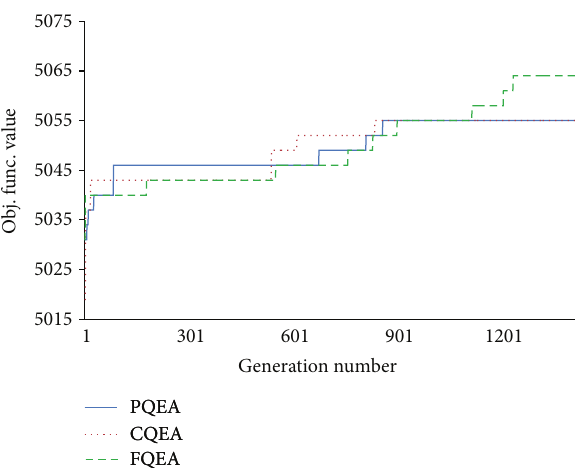
Figure 31: Convergence graph of PQEA, CQEA, and FQEA on 0-1 knapsack problem with profit ceiling data instances with number of items, 𝑀 , being 200 and capacity, 𝐶 , being 2% of total weight.